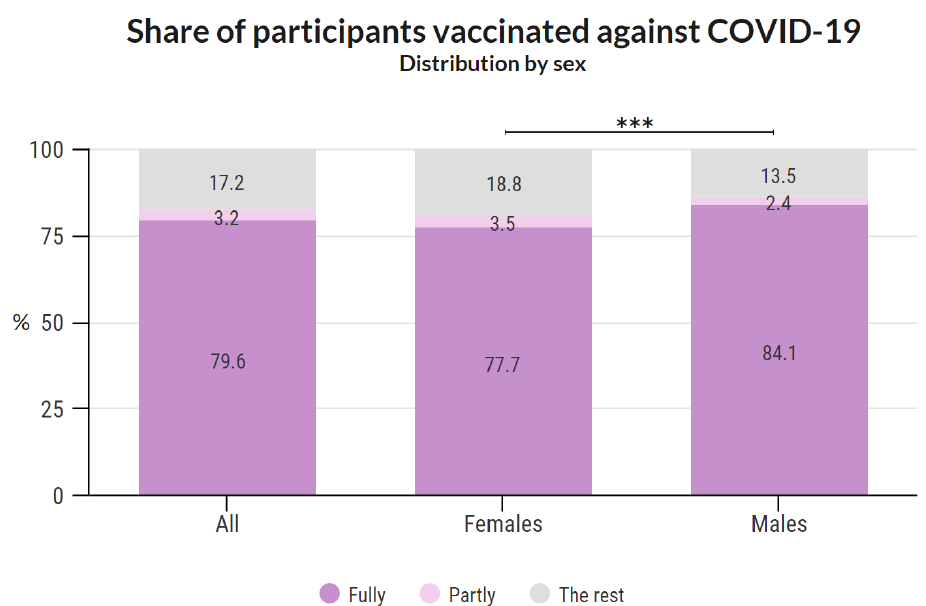
Figure 4. Share of participants vaccinated against COVID-19 based on sex. The difference in vac- cination with at least one dose between males and females was statistically significant (*** indicates p = 0.001; chi-square with Yates’ correction; OR = 1.48, 95% CI 1.045 to 1.862).